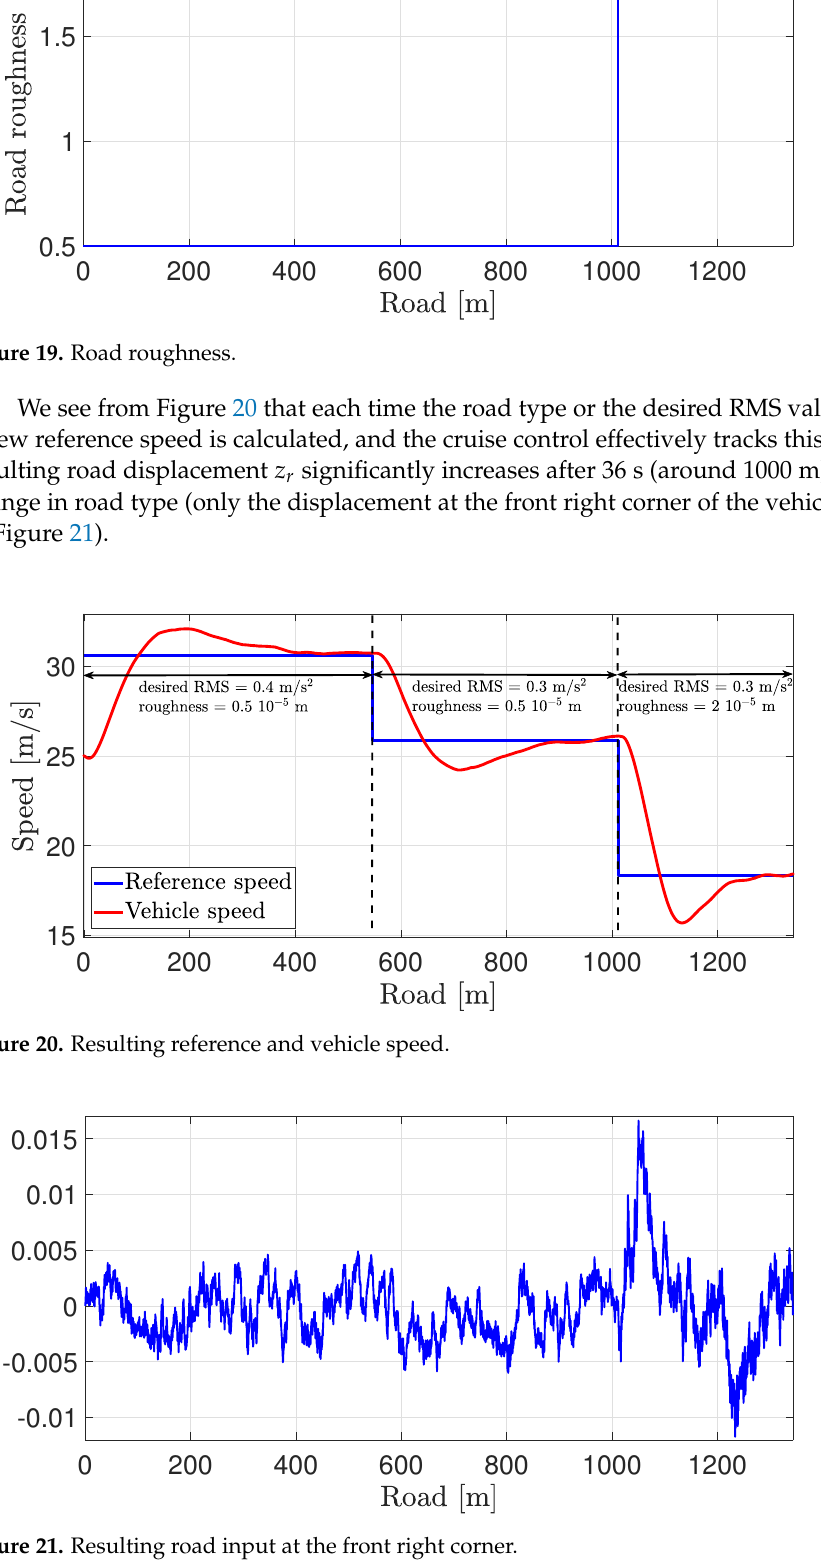
Figure 21. Resulting road input at the front right